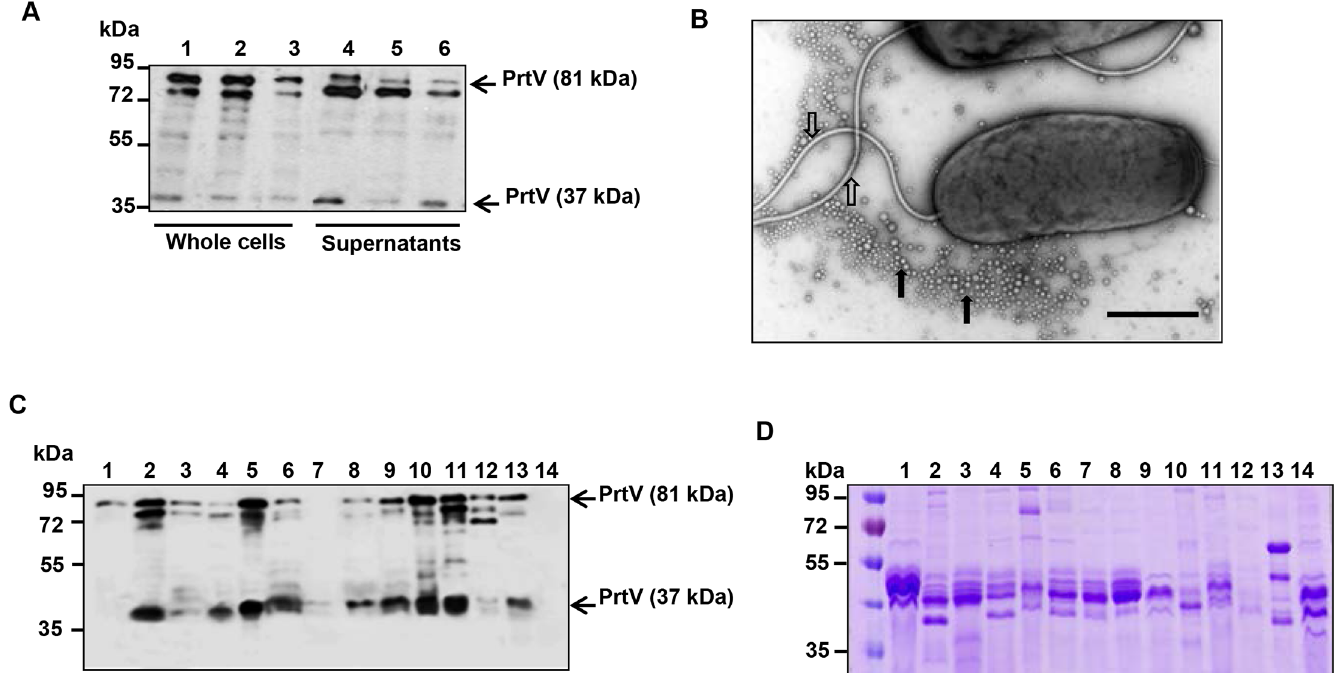
Fig 1. Immunoblot analyses of PrtV expression and secretion and ultrastructural analysis of V . cholerae surface structures. (A) Immunoblot analysis of expression and secretion of PrtV in different V . cholerae O1 isolates. Bacterial strains were grown at 30°C and samples were collected at OD 600 2.0. Samples of whole cell extracts from overnight cultures (lanes 1 – 3, 5 μ l) and culture supernatants (lanes 4 – 6, 10 μ l, corresponding to tenfold concentration compared with the whole cell samples) were loaded in the gel. Immunoblotting was done using anti-PrtV polyclonal antiserum. Lanes 1 – 3; whole cell lysates; lanes 4 – 6: culture supernatants from wild type V . cholerae El Tor O1 strains A1552, C6706, and P27459 respectively. (B) Ultrastructural analysis of V . cholerae by electron microscopy. An electron micrograph showing the flagella (open arrows) and OMVs (closed arrows). Bar, 500 nm. (C) PrtV association with OMVs from different V . cholerae isolates. Immunoblot analysis of OMVs from different V . cholerae isolates using PrtV polyclonal antiserum. Bacterial strains were grown at 30°C for 16 h and OMVs were isolated using the procedure described in Materials and Methods. 10 μ l of OMV samples were loaded for immunoblot analyses and SDS-PAGE analyses by Coomassie blue staining. Lanes 1 – 6; OMVs from V . cholerae non-O1/non-O139 serogroup: V:52, V:5/04, V:6/04, KI17036, 93Ag19, and NAGV6; lanes 7 – 9: OMVs from V . cholerae O1 El Tor clinical isolates: P27459, C6706, and A1552; lane 10: OMVs from V . cholerae classical O1 strain 569B; lanes 11 – 13: OMVs from V . cholerae O1 environmental isolates: AJ4, AJ3, and AJ2. Lane 14, C6706 Δ prtV mutant.